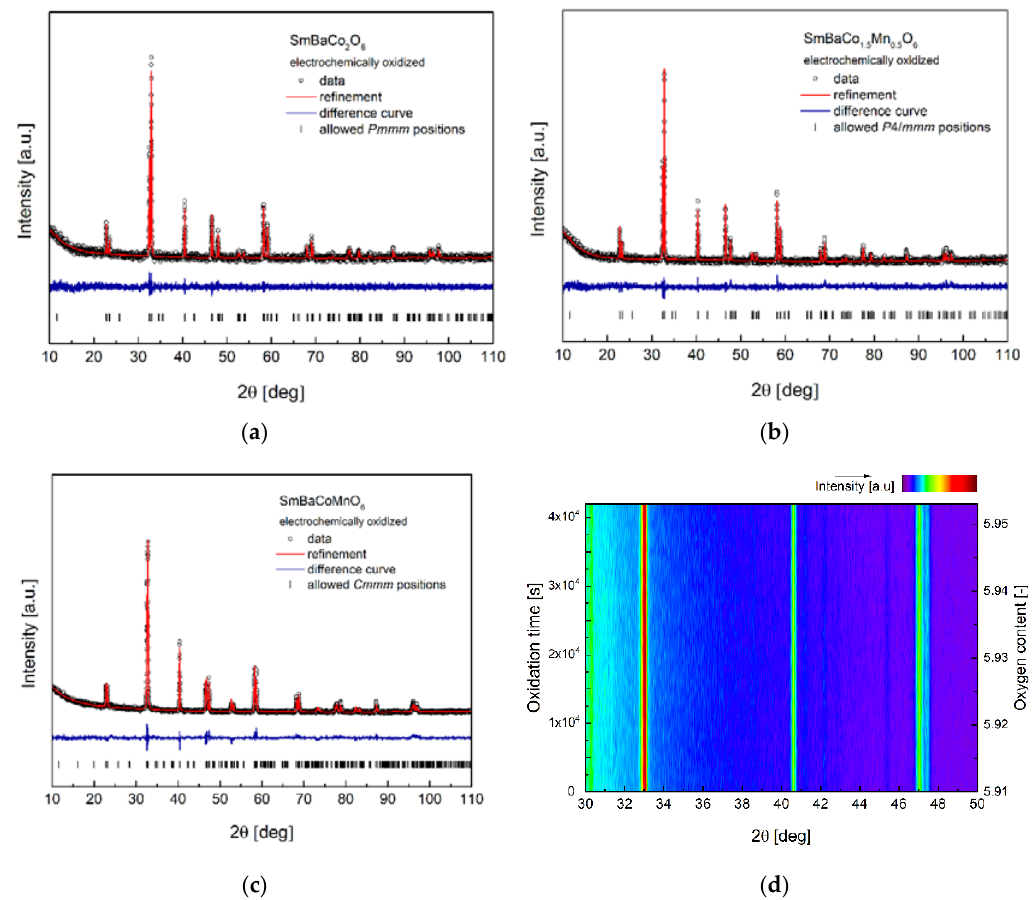
Figure 4. ( a ) X ‐ ray diffraction (XRD) data with Rietveld refinement for electrochemically oxidized SmBaCo 2 O 6 ; ( b ) XRD data with Rietveld refinement for electrochemically oxidized SmBaCo 1.5 Mn 0.5 O 6 . ( c ) XRD data with Rietveld refinement for electrochemically oxidized SmBaCoMnO 6 ; ( d ) Operando XRD data (matrix of points) recorded for SmBaCoMnO 5+ δ during galvanostatic electrochemical oxidation. Data presented as a function of time and oxygen content calculated on the basis of initial and final oxygen contents measured with iodometric titration (constant effectiveness of the process was assumed).